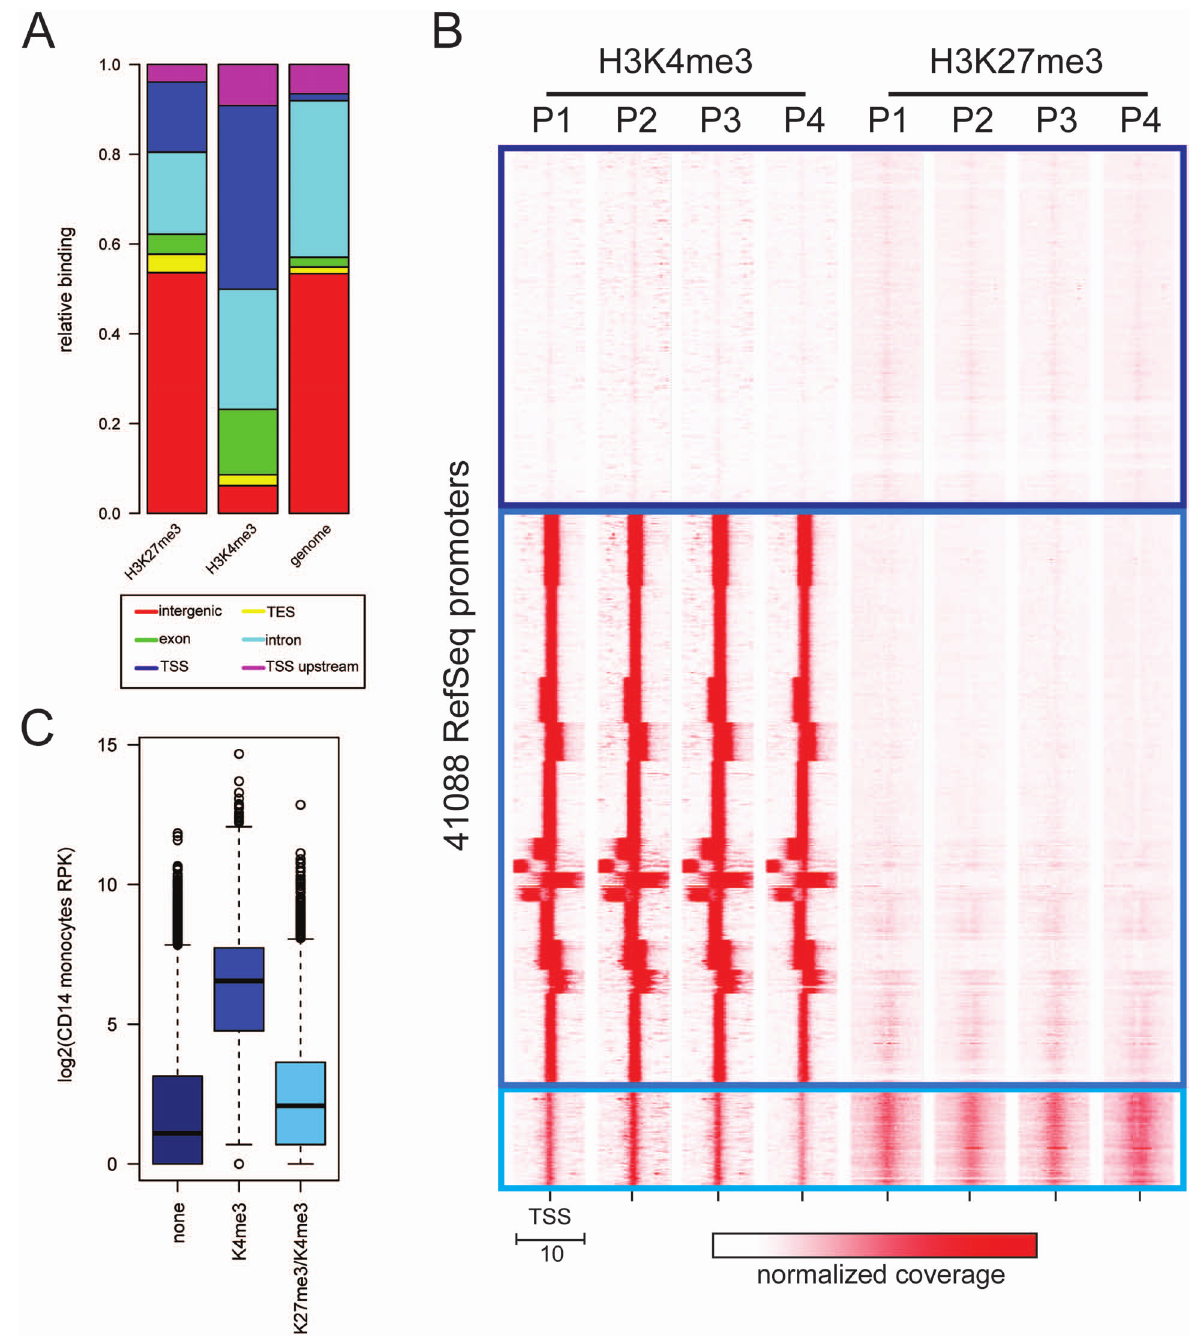
Figure 4. Histone modifications at promoters of CD 14 ++ CD 16- monocytes. A) H3K4me3 and H3K27me3 are both enriched at promoters. Significantly bound regions were compared with the distribution of genomic features (TSS, TSS upstream, TES, exon, intron, intergenic) based on RefSeq gene annotations. In comparison to the genomic background (genome) both H3K27me3, but especially H3K4me3 are strongly enriched for TSSs. B) K-means clustering reveals 3 major chromatin states at 44109 RefSeq transcriptional start sites. The heat map shows binding (in red) centered across a 10 kb interval spanning all RefSeq TSSs for H3K27me3 and H3K4me3 in 4 blood donors. The data was clustered by k-means which separates the data into 3 major promoter classes: no histone modification (dark blue), high H3K4me3/no H3K27me3 (blue) and low but detectable H3K4me3 and high H3K4me3 (light blue). C) Promoter classes are associated with specific transcriptional output. Gene expression levels in CD14 + monocytes were calculated for all RefSeq genes (based on ENCODE RNA-seq data, shown as reads per 1 kb of transcript length). Gene expression values of genes falling into above mentioned categories are plotted as boxplots.